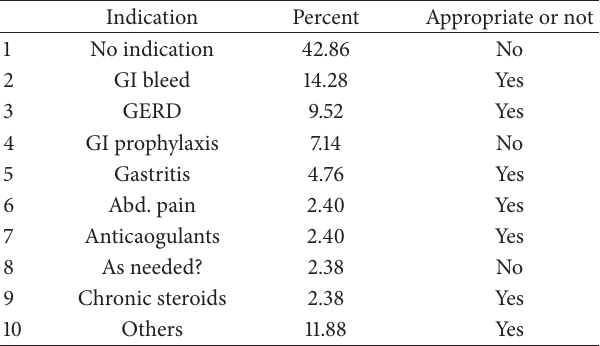
Table 2: Indications for discharge on